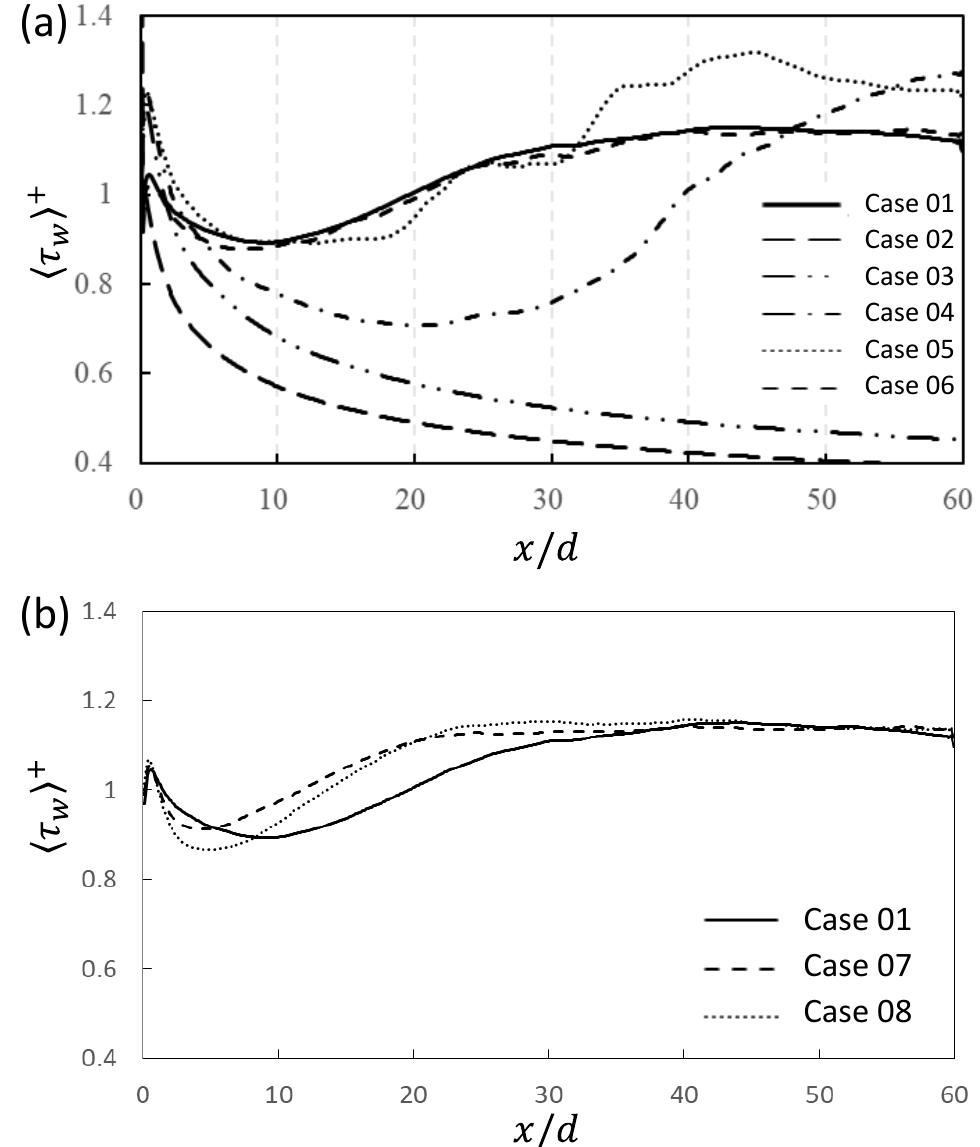
Figure 7. Development of dimensionless wall shear stress with different length scales. ( a ) Cases 01–06 ( b ) Cases 01, 07 and